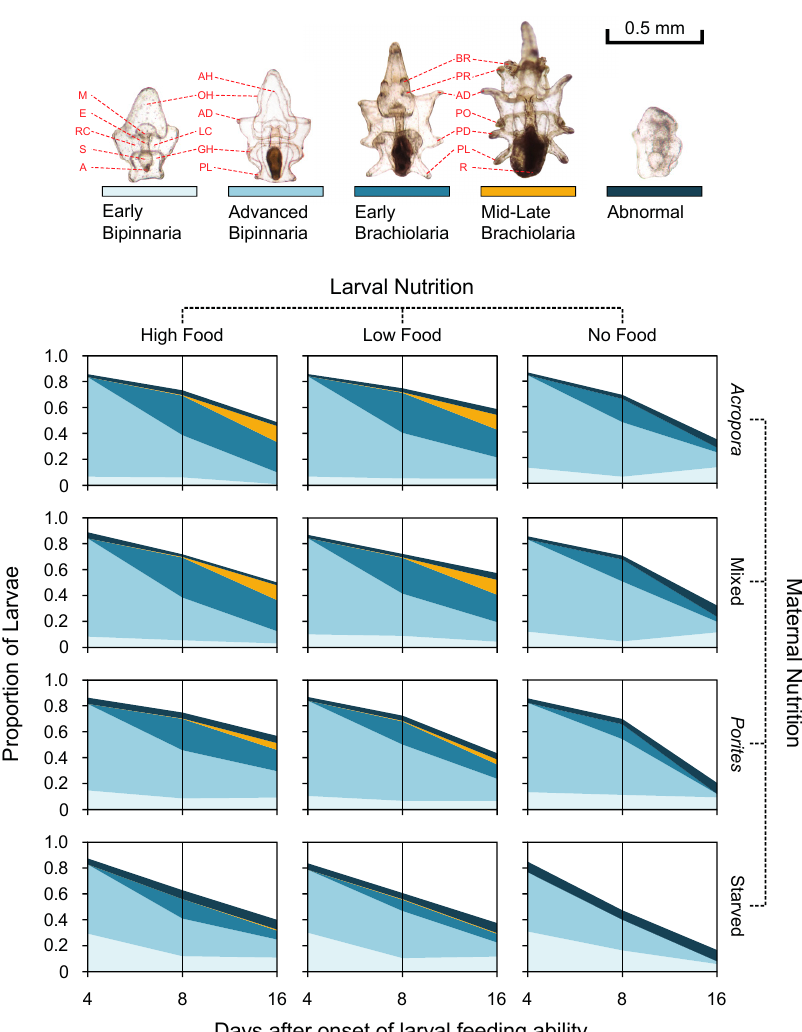
Figure 3. Larval survival and progression of larval development at 4, 8, and 16 days. Morphological traits used in scoring larvae are: mouth ( M ), esophagus ( E ), right coelomic pouch ( RC ), stomach ( S ), anus ( A ), axohydrocoel ( AH ), oral hood ( OH ), anterodorsal arm ( AD ), left coelomic pouch ( LC ), gut hood ( GH ), posterolateral arm ( PL ), brachiolar arm ( BR ), preoral arm ( PR ), anterodorsal arm ( AD ), postoral arm ( PO ), posterodorsal arm ( PD ), posterolateral arm ( PL ), and rudiment ( R ).